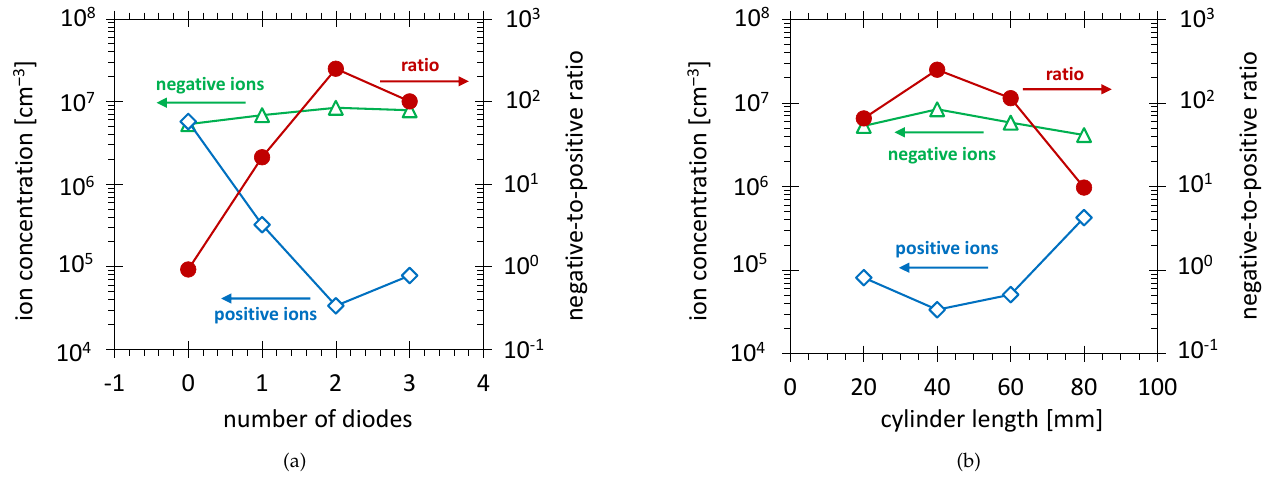
Figure 3. The ion concentrations and negative-to-positive ion concentration ratio for ( a ) different number of diodes at ion filter cylinder length of 40 mm, and ( b ) varying length of the ion filter cylinder with two diodes. Measurements are conducted in PCPG configuration 1 with the power of 4.5